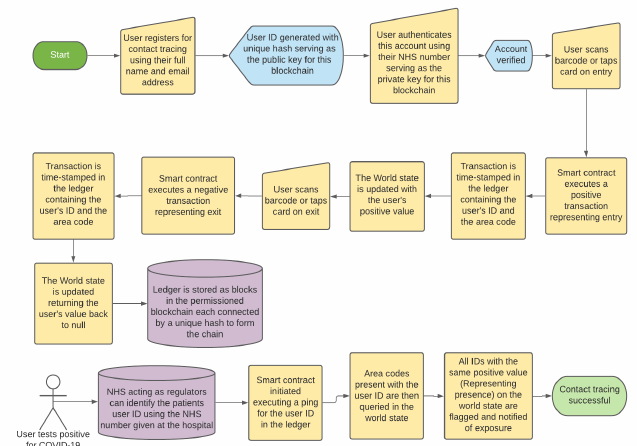
Figure 4: Blockchain contact tracing